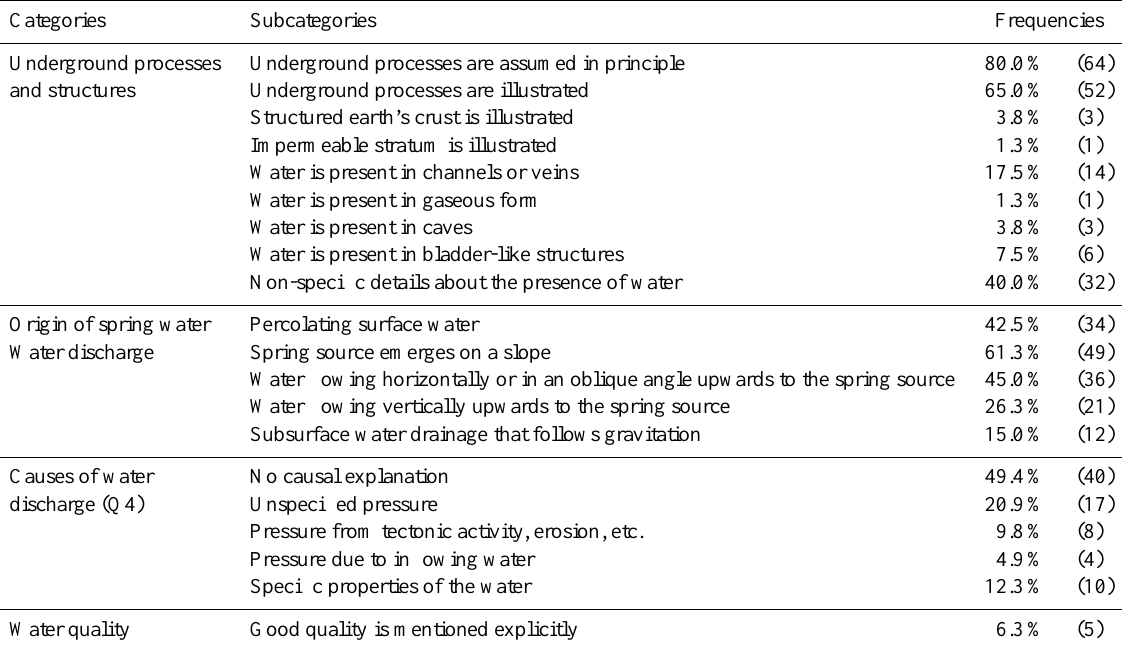
Table 2. Frequency of the subcategories identified in the students’ drawings and in the students’ answers to the item Q4 (see Sect. 5.3) related to the total sample ( n =80) in percentage values (absolute figures in brackets); several subcategories may occur simultaneously in one and the same